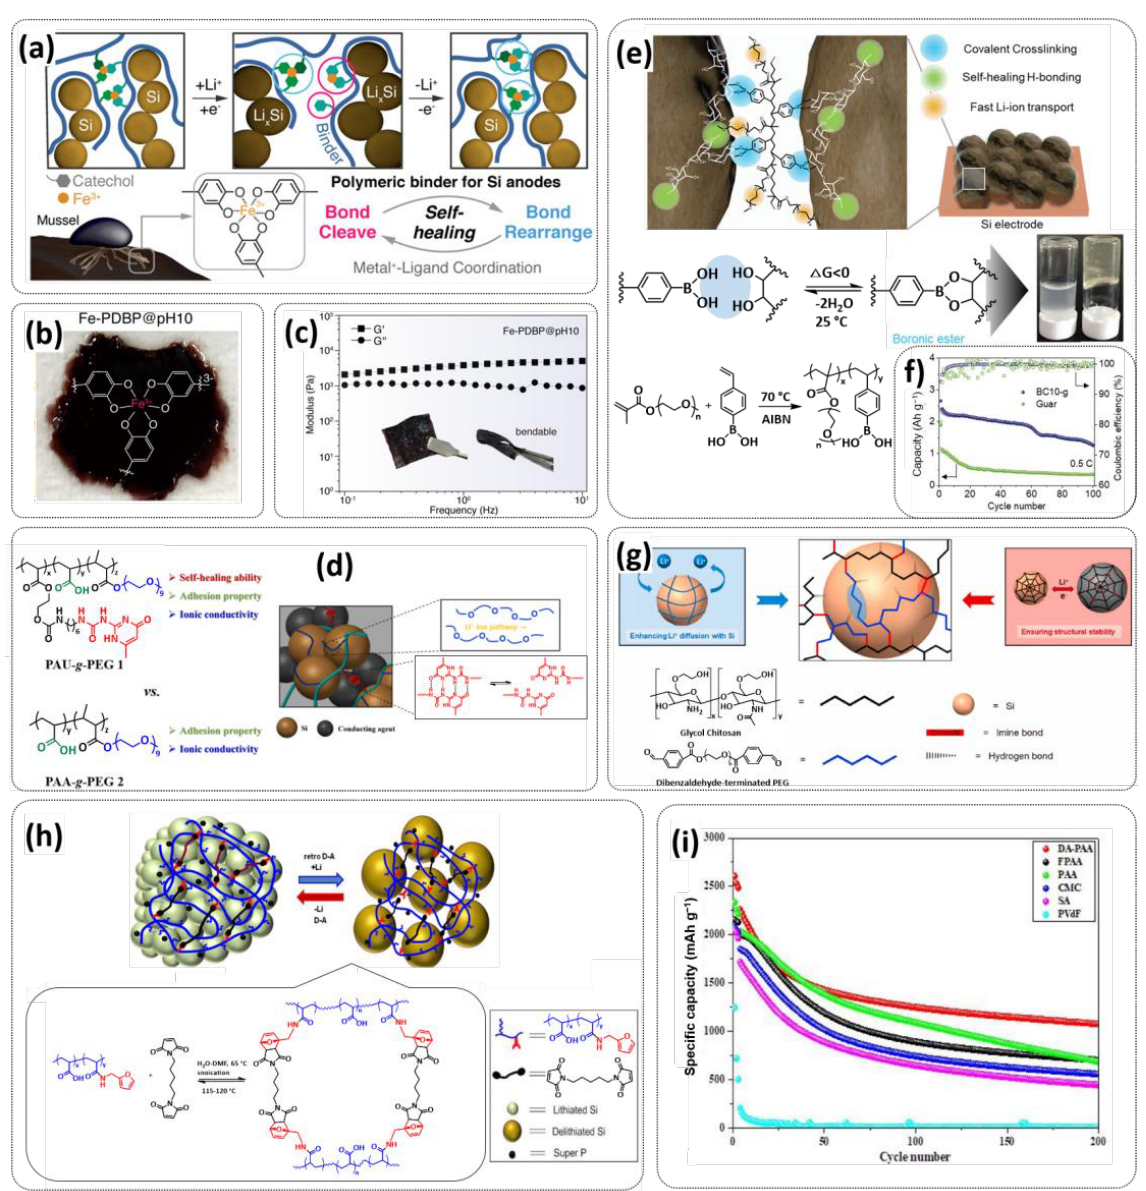
Figure 17. ( a ) Illustration of the self-healing mechanism of metallopolymer Fe – PDBP. ( b ) PDBP in the presence of FeCl 3 at pH = 10. ( c ) Rheology of Fe – PDBP@pH10 in a frequency range from 10 – 1